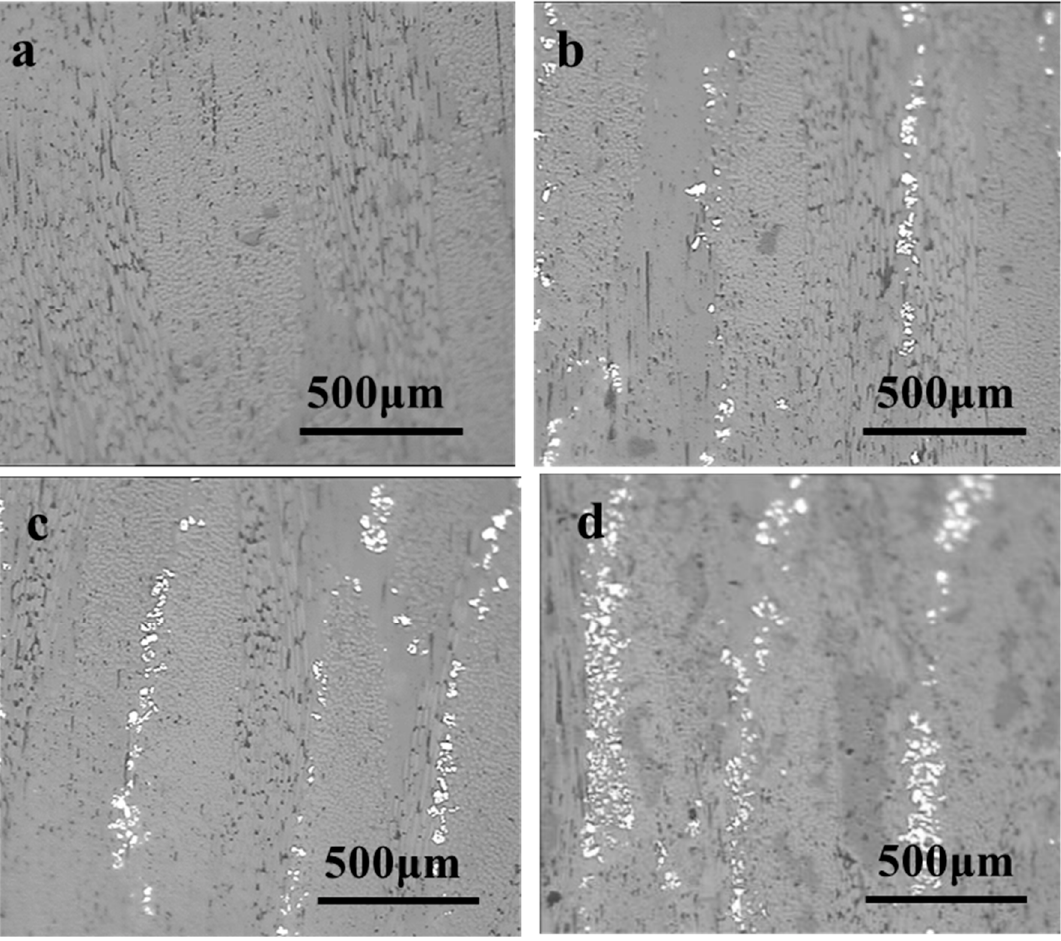
Figure 3. Spatial distribution of MRP in resin transfer molded (RTM) composites. Optical microscope images for the sections of RTM epoxy composites preformed by ET3228 tackifiers containing ( a ) 0, ( b ) 23, ( c ) 38 and ( d ) 48 wt.% MRP. The sections of the composites are vertical to the reinforced fabrics.